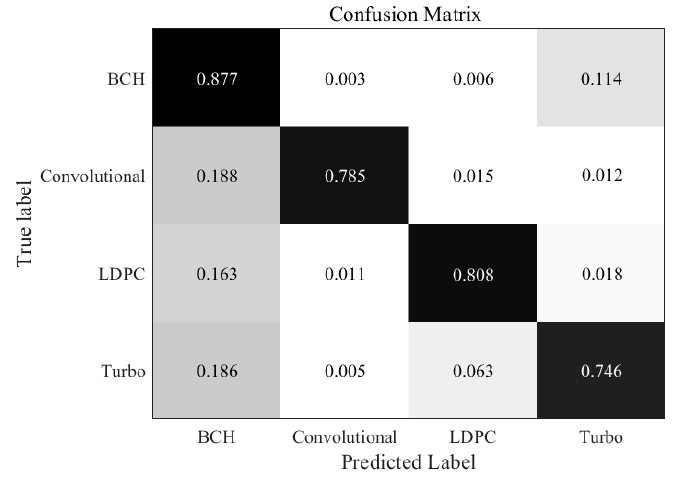
Figure 7. Confusion matrix for improved RNN trained at − 5 dB SNR.